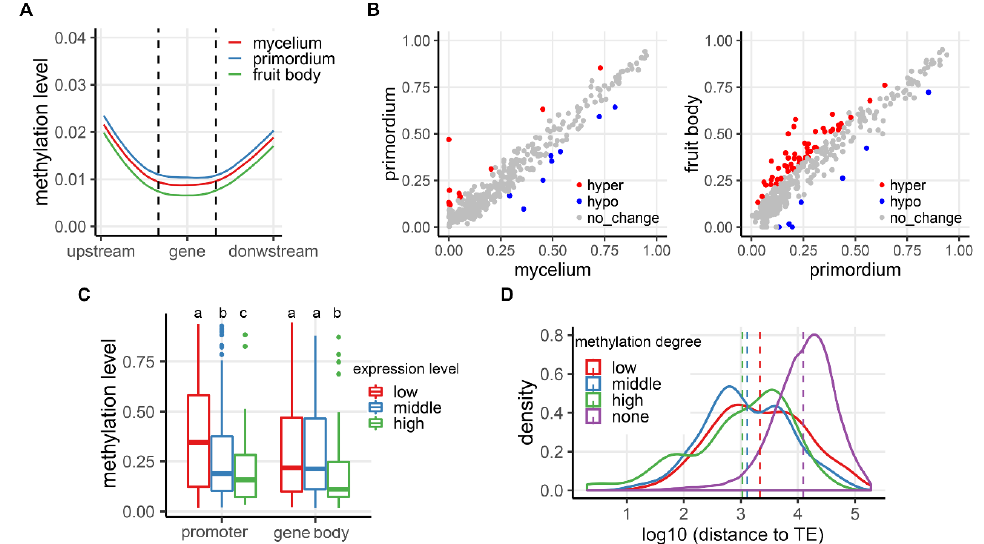
Figure 4. mCG and expression levels in protein-coding genes of Pleurotus tuoliensis (Pt). ( A ) Meta-plots of mycelium (M, red), primordium (P, blue) and fruit body (F, green) methylation levels in genic regions. ( B ) Correlation of mCG levels in promoter regions during transition 1 (from mycelium to primordium, left panel) and transition 2 (from primordium to fruit body, right panel). The red, blue and grey dots indicate hyper-methylated, hypo-methylated and unmethylated promoters, respectively. ( C ) Effects of mCG in promoters and gene bodies on gene expression (genes harboring methylated promoters or gene bodies were divided to low, medium and high expression classes). ( D ) Distribution of distances between different types of promoters (with respect to mCG) to their nearest TEs (none, low, medium, high mCG-containing promoters). Very similar profiles were obtained for Pe, shown in Figure S6.